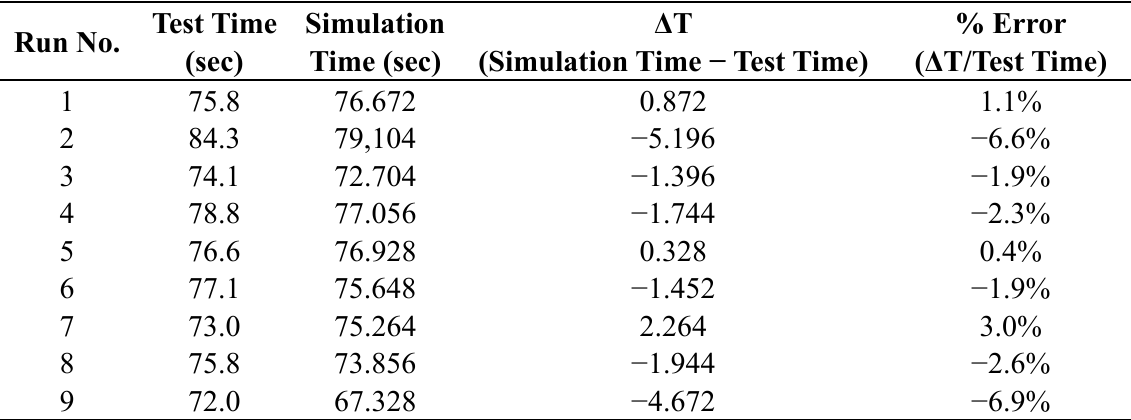
Table 2. Comparison of coast-down time between experiment and simulation.